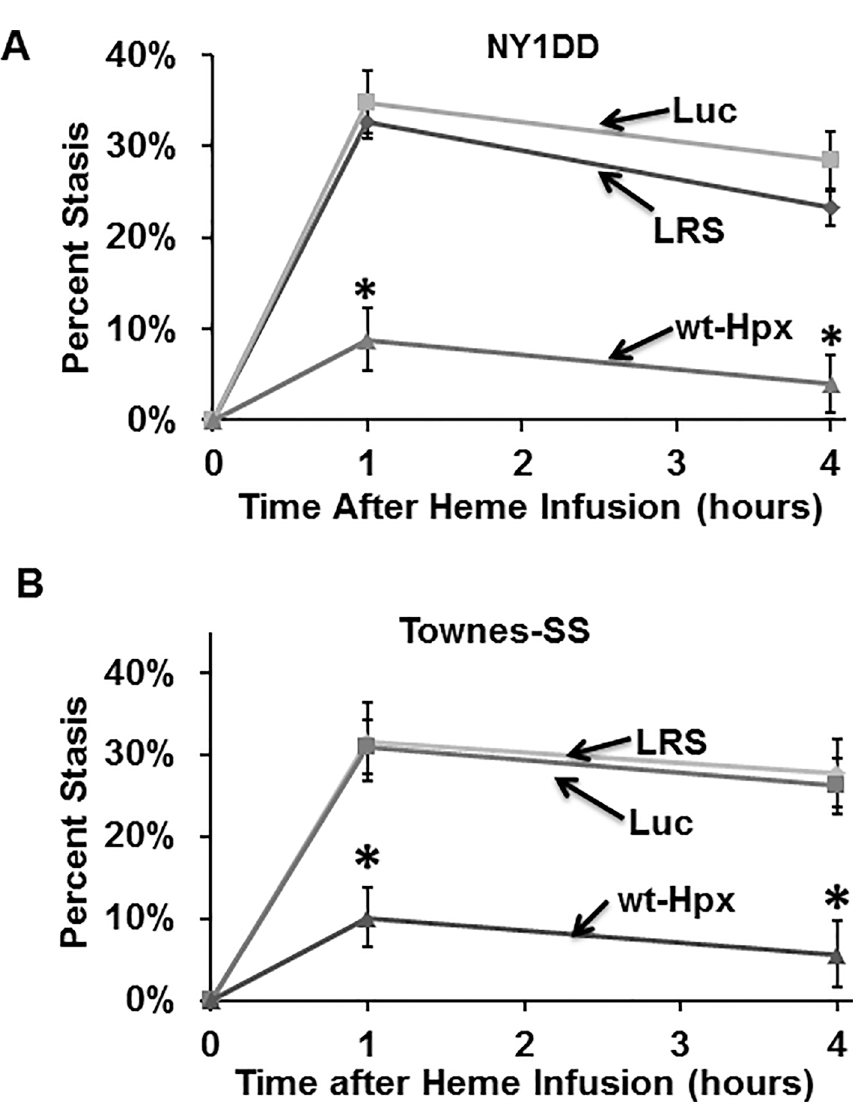
Figure 4. Hemopexin gene therapy inhibits heme-induced microvascular stasis in sickle mice. NY1DD (A) and Townes-SS (B) mice were hydrodynamically infused with lactated Ringer’s solution (LRS), SB 100X + Luc, or SB 100X + wt-Hpx [NY1DD (n = 4) and Townes-SS: LRS and wt-Hpx (n = 3) and Luc (n = 2)]. DSFCs were implanted 4 wks later and micro- vascular stasis was measured at 1 h and 4 h after infusion of heme (3.2 μ mols/kg). Per- centage of stasis (mean ± SD) was calculated at each time point. * P < 0.05 for wt-Hpx compared with